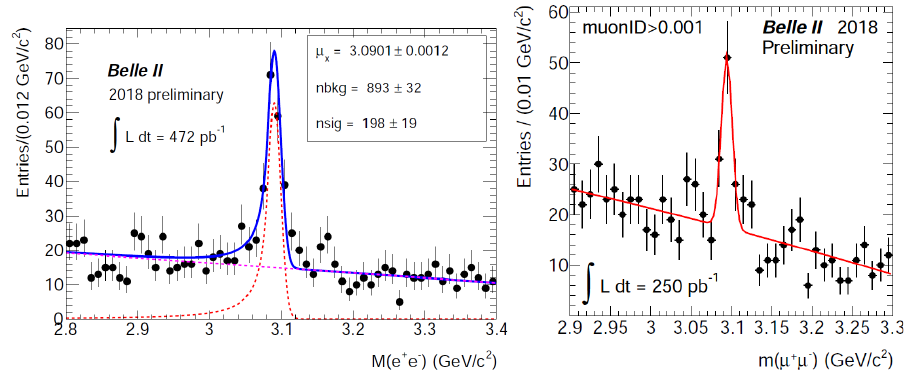
Figure 3. Reconstruction of J /ψ → e + e − (Left) and J /ψ → µ + µ − (Right) using di ff erent Phase-2 data sets at Belle II. PID is applied in this tests. The dotted red line (Left) refers to MC simualtions; the continuum line is the fit to the data.